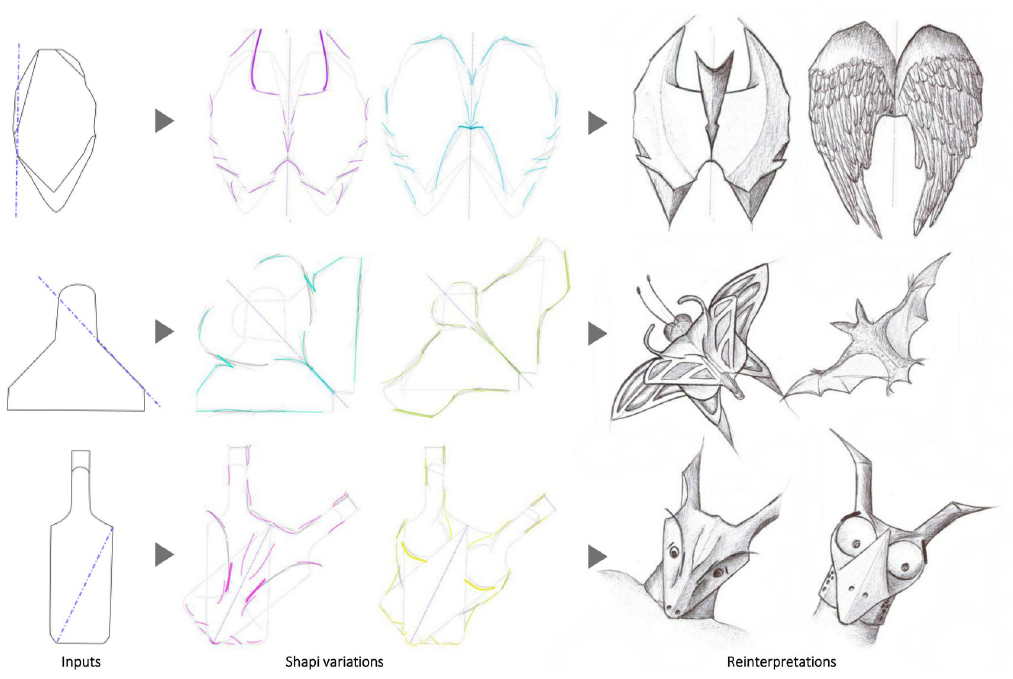
Fig 18. Using an abstract Seed to generate new emerging patterns that inspire divergent human